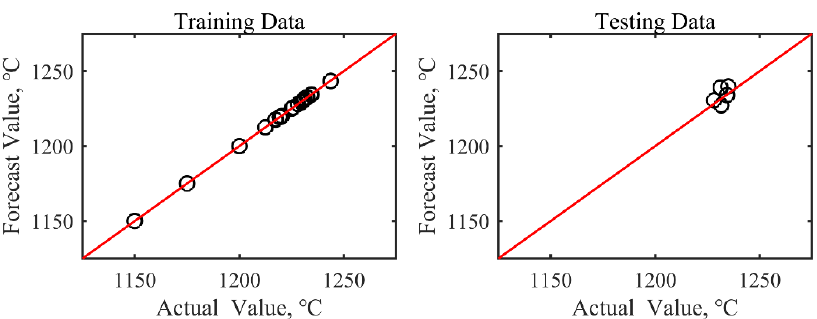
Figure 10. Actual value and forecast value of T sp 6.